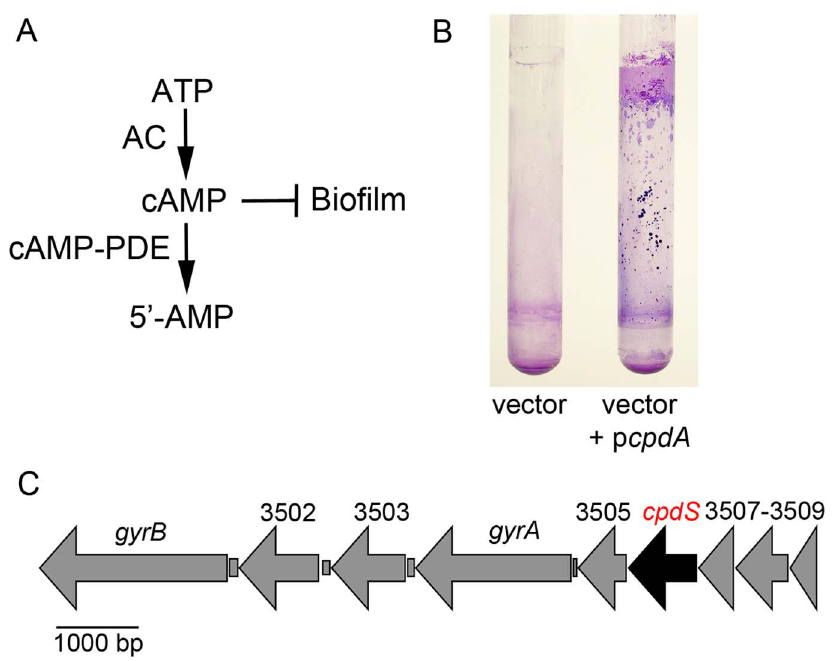
Figure 1. Role of cAMP-phosphodiesterase activity in biofilm formation and identification of a cAMP-phosphodiesterase gene in the S.marcescens genome. A. Model for cAMP metabolism and inhibitory effect on biofilm production. Adenylate cyclase (AC) catalyzes synthesis of cAMP from ATP, whereas cyclic-AMP phosphodiesterase (cAMP-PDE) catalyzes hydrolysis of cAMP to 5 9 -AMP. B. Crystal violet stained biofilms on the side of test tubes formed under high-sheer conditions. Shown is a wild-type S. marcescens strain with either the empty vector or the vector with a wild-type copy of the E. coli cAMP-PDE gene, cpdA . C. Genomic context of the S. marcescens cpdS gene, a candidate cAMP-PDE gene.